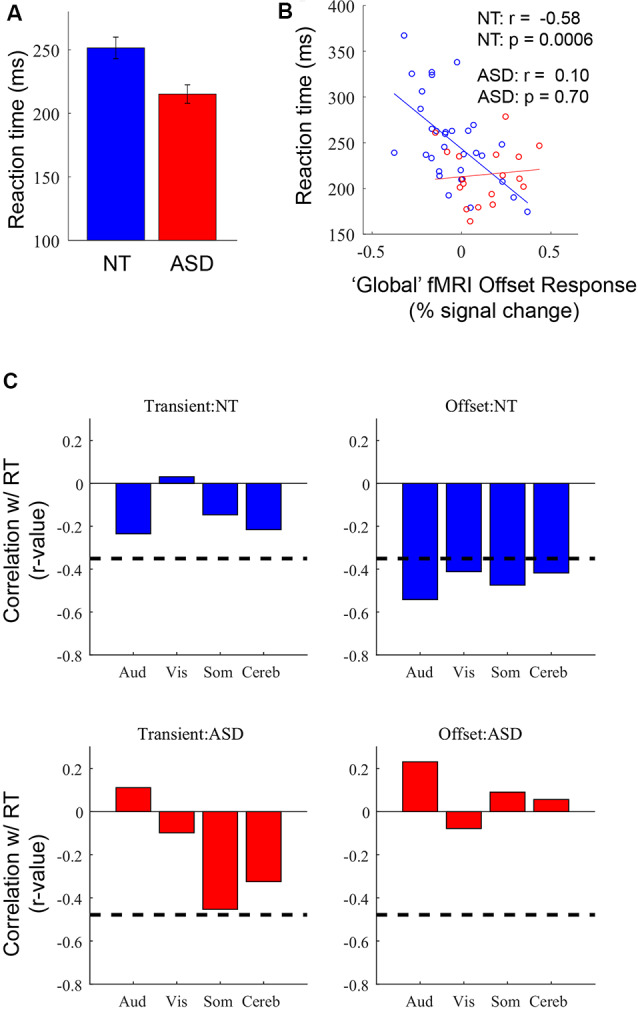
(A) Average reaction time (RT) in NT and ASD participants. (B) Correlation between RT and offset response amplitude averaged across the four ROIs in NT (n = 32; blue) and ASD (n = 18; red) participants. (C) Correlations between transient and offset response magnitudes with RT in each of the four ROIs. Dashed line represents p = 0.05.